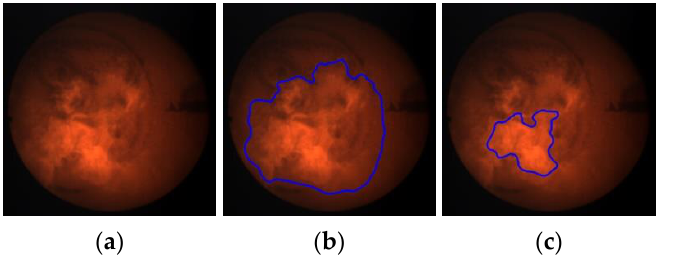
Figure 6. Impact of gamma correction on the segmentation quality: ( a ) exemplary flame image belonging to Variant 7; ( b ) segmentation result without gamma correction (the segmented object includes also the large background area); ( c ) segmentation result after gamma correction.